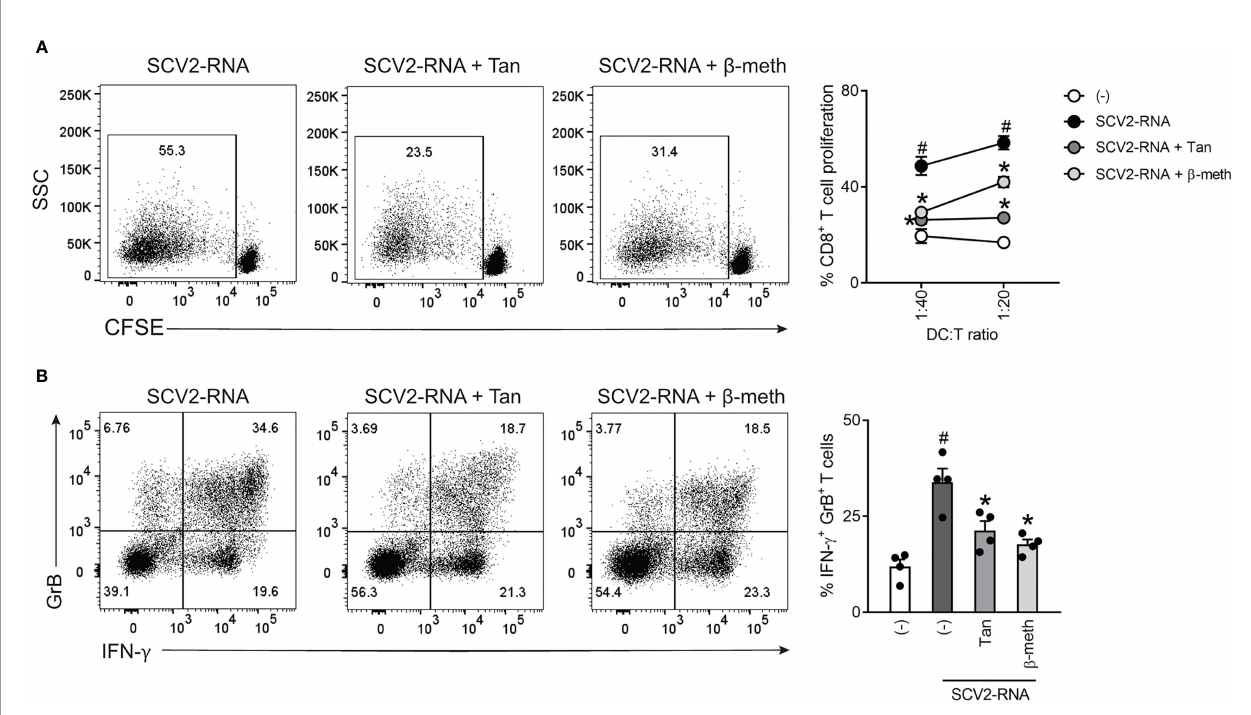
FIGURE 3 | Effect of Tanimilast on CD8 + T cell activation by SCV2-moDCs. (A) moDCs were treated or not (-) with either Tanimilast (Tan) or b -methasone ( b -meth) (both at 10 -7 M) for 1 hour and then stimulated with SCV2-RNA. After 24 hours, moDCs were collected and co-cultured with graded numbers of CFSE-stained allogenic CD8 + T cells for 6 days. Alloreactive T cell proliferation was assessed by measuring CellTrace-CFSE dye loss by fl ow cytometry. Left, dot plot from one representative experiment (1:40 ratio). Right, line graphs from three independent experiments with different DC:T cell ratio. Data are expressed as mean ± SEM (n=3) of the percentage of proliferating CD8 + T cells. (B) moDCs treated as described in (A) were co-cultured with graded numbers of CD8 + T cells for 6 days. Intracellular IFN- g and Granzyme B (GrB) were evaluated by FACS analysis. Left, dot plot from one representative experiment. Right, bar graphs from four independent experiments. Data are expressed as mean ± SEM (n=4) of the percentage of double positive T cells. (A, B) # P versus (-) and *P< 0.05 versus SCV2-RNA by one-way ANOVA with Dunnett ’ s post-hoc